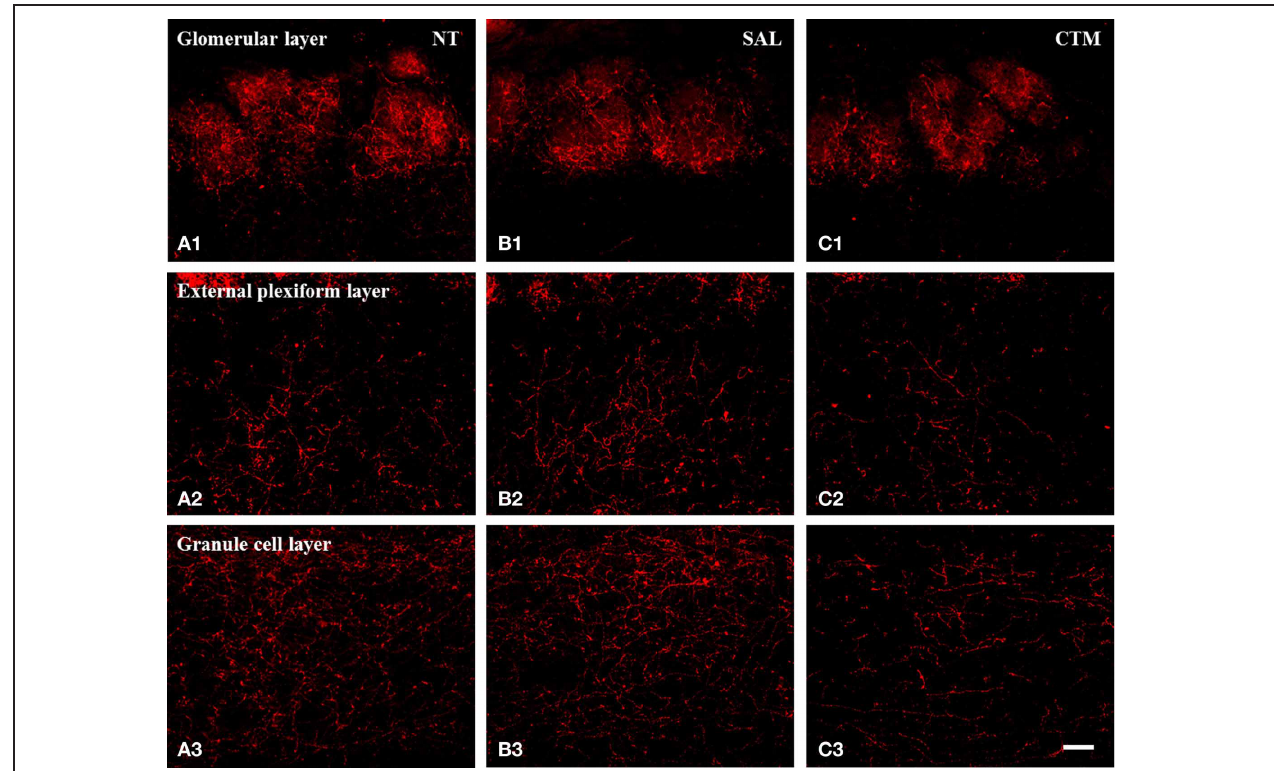
FIGURE 2 | Representative photomicrographs illustrating the distribution pattern of SERT-ir fibers in the OB of male rats. (A1–C1) The glomerular layer. (A2–C2) The external plexiform layer. (A3–C3) The granule cell layer. Note that SERT-ir fiber density in CTM